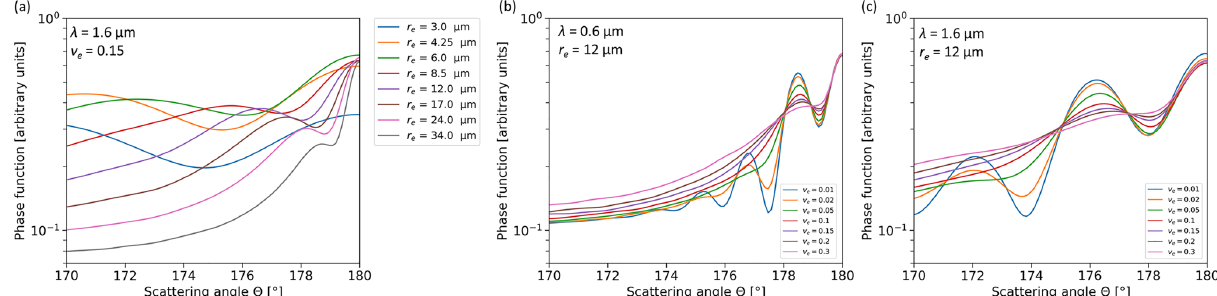
Figure 6. Dependence of the scattering phase function on r e and ν e in the backscattering directions. (a) Phase functions at 1.6µm wavelength used in the radiative transfer calculations for the eight r e values of the LUTs, assuming ν e = 0 . 15. (b) Phase functions at 0.6µm wavelength used in the radiative transfer calculations for the seven ν e values of the LUTs, assuming r e = 12µm. (c) Same as in (b) but for phase functions at 1.6µm.